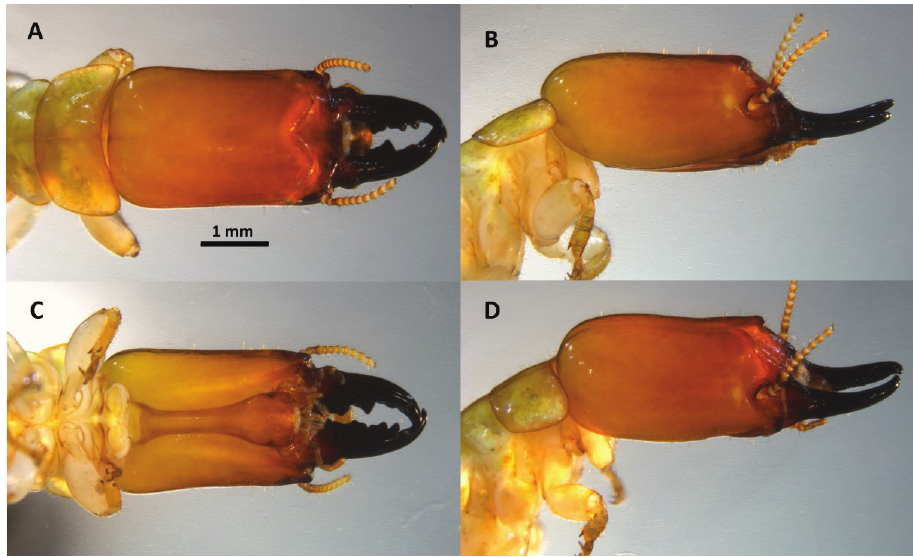
Figure 4. Head and pronotum of Neotermes aburiensis soldier . A Dorsal B lateral C ventral, and D oblique views. Table 2. Measurements of Neotermes aburiensis soldier (n=5). Measurement max. min.